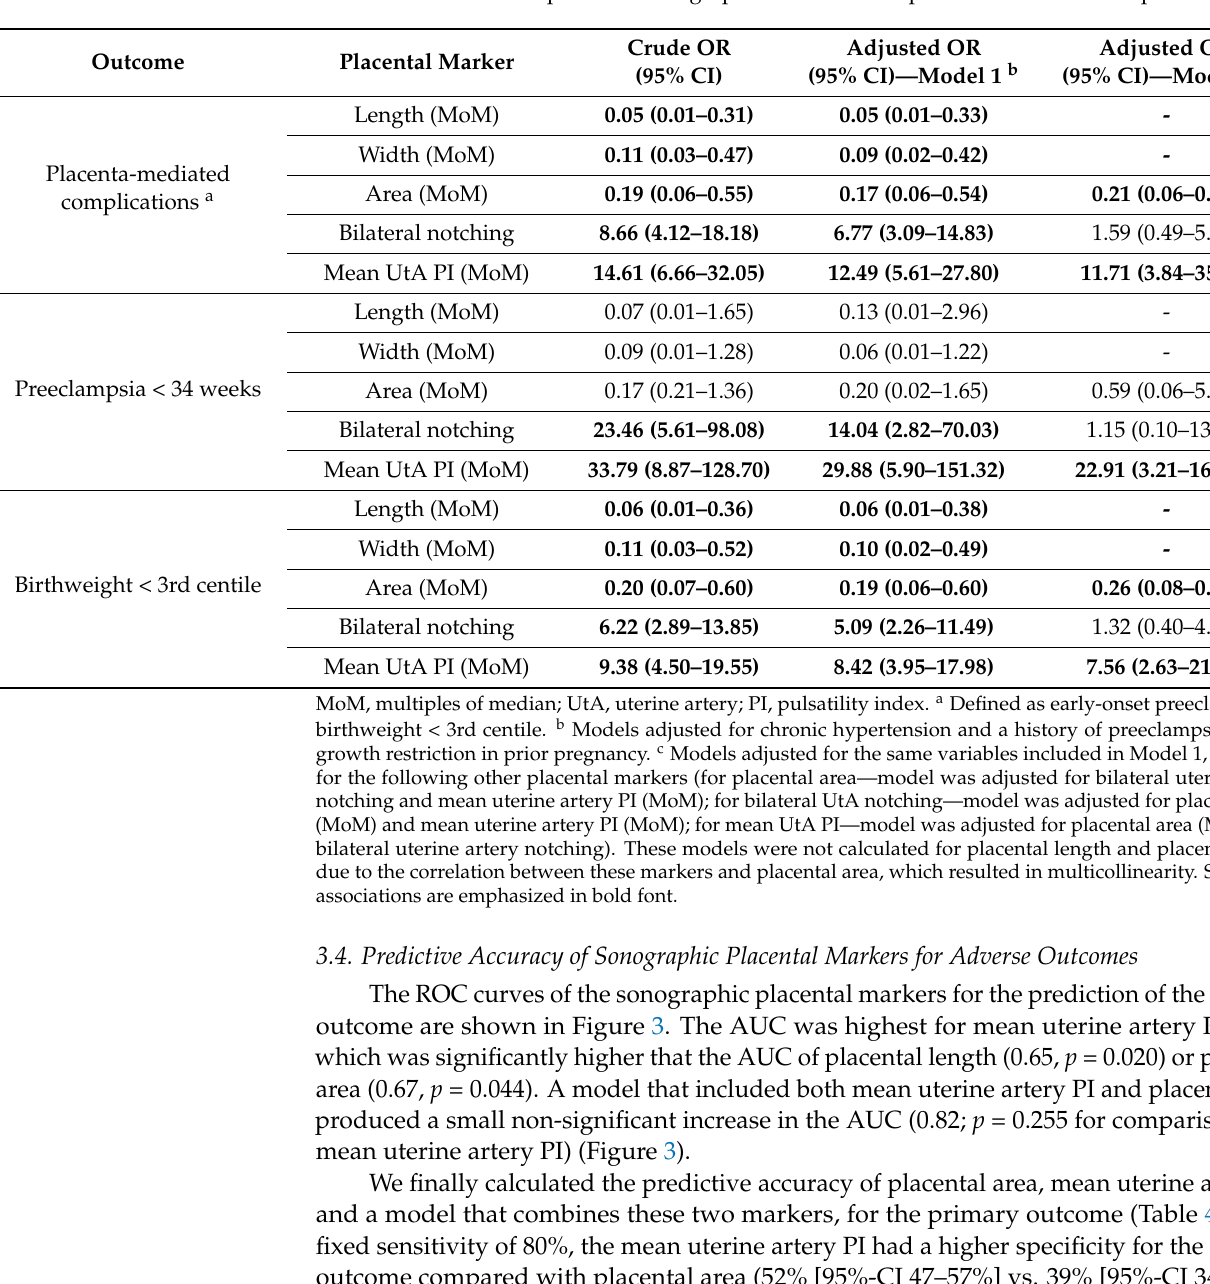
Table 3. Association of placental sonographic markers with placenta-mediated